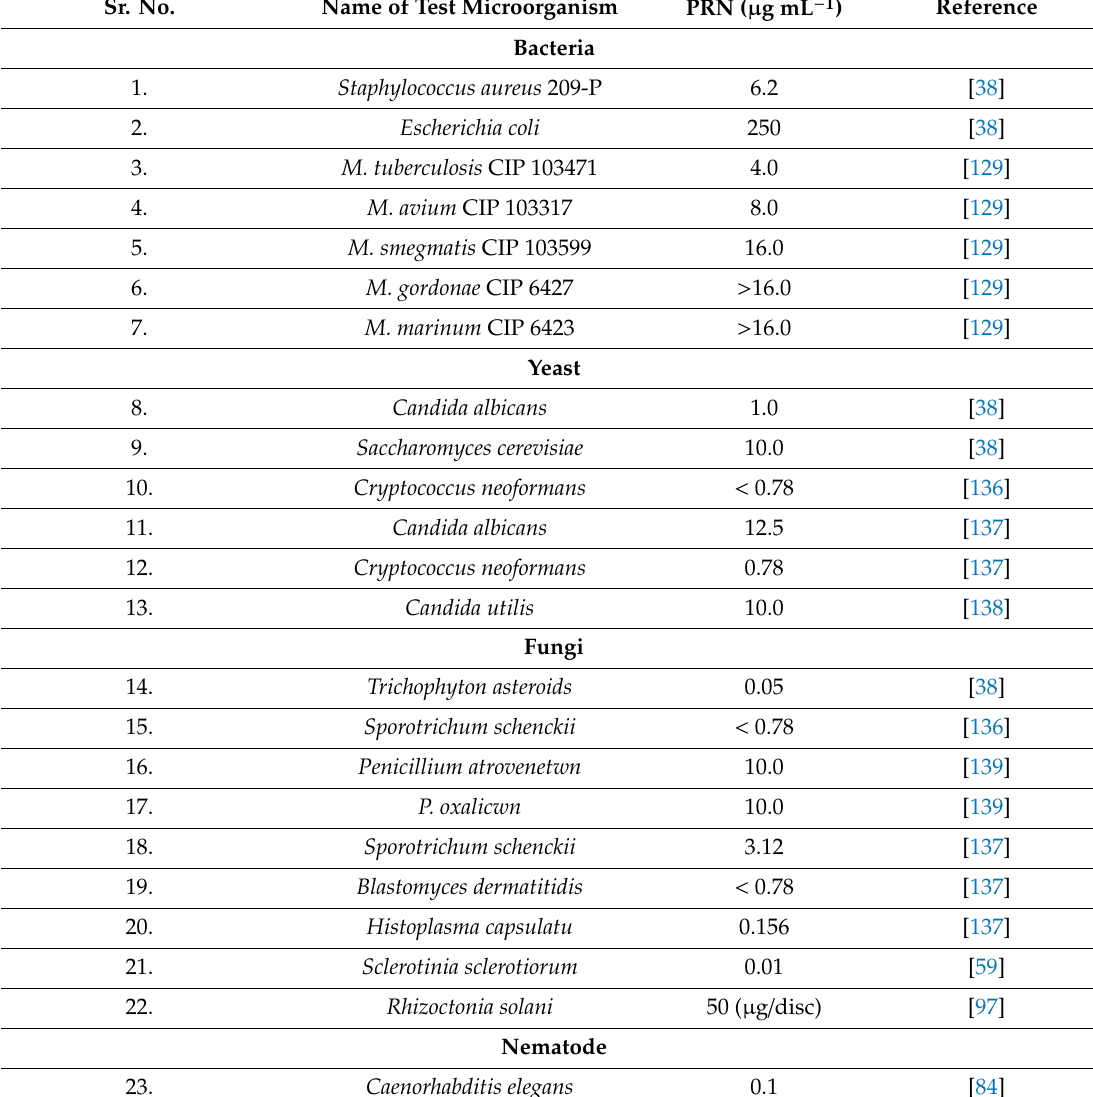
Table 6. Bioactivity spectrum of pyrrolnitrin against bacteria, fungi and nematodes. Sr.